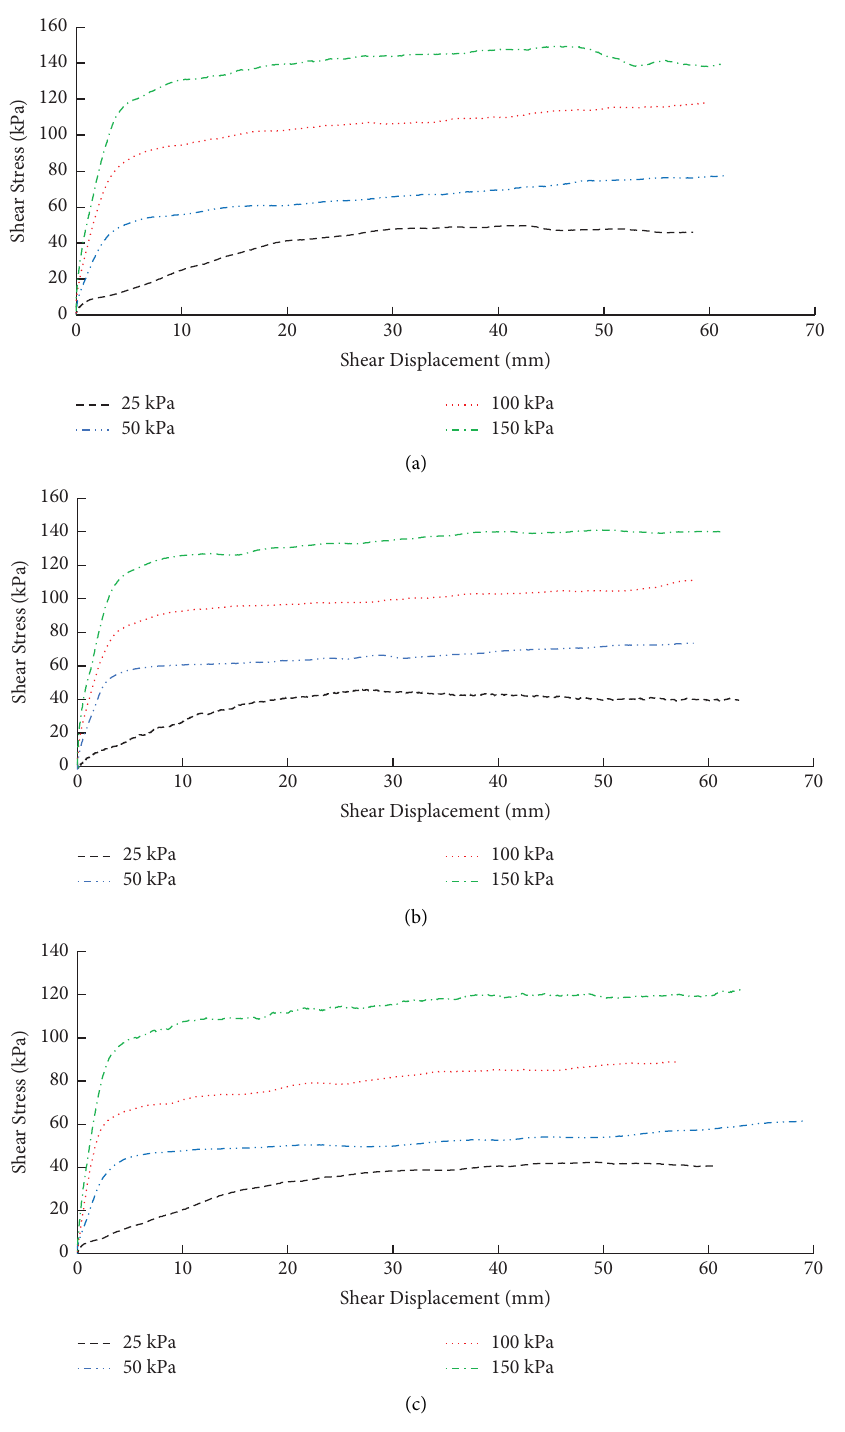
Figure 16: Relationship curve between shear stress and shear displacement under diferent percentages of the transverse ribs of the geogrid. (a) 100% geogrid transverse ribs. (b) 75% geogrid transverse ribs. (c) 50% geogrid transverse